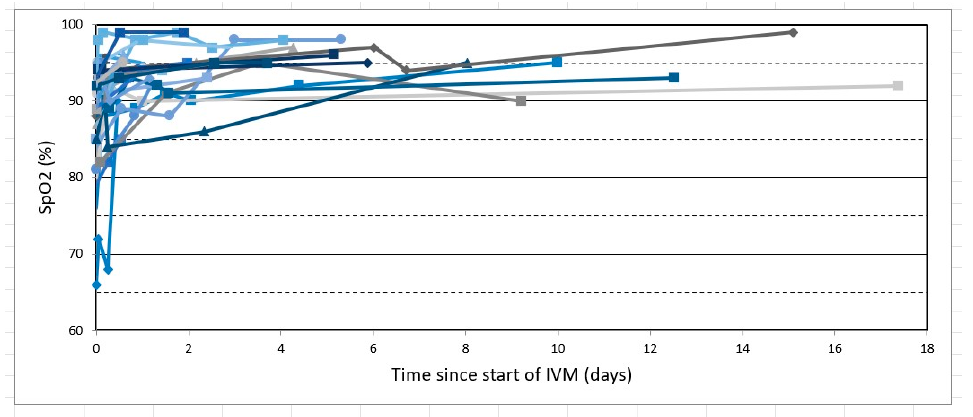
Figure 3. All SpO2 values (on room air) for the 34 severe COVID-19 patients of this study, all treated with IVM-based combination therapy including IVM, doxycycline, and zinc. Each patient is represented by joined line segments of a different color, with markers designating SpO2 values recorded.